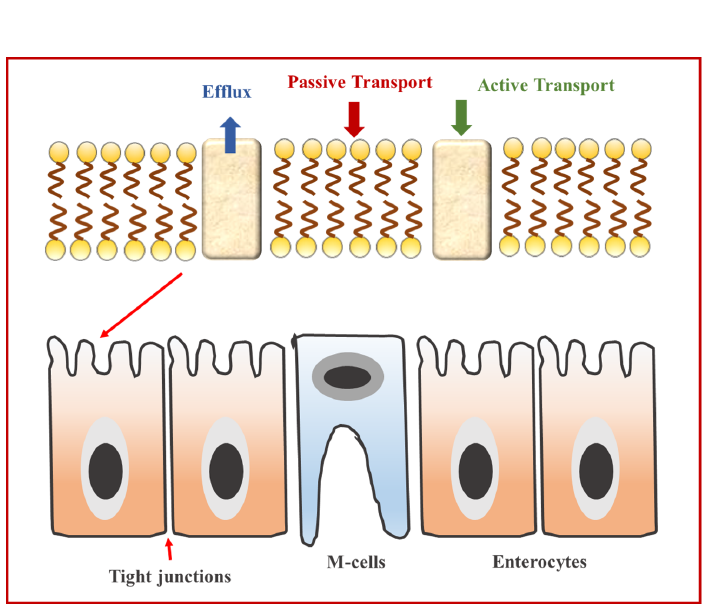
Figure 4. Schematic representation of the mechanisms involved in the absorption of bioactive compounds in the gastrointestinal tract. The absorption of bioactive agents may be limited due to their transport across the epithelium cell through passive, active or efflux mechanisms. Most bioactive compounds are usually absorbed in the upper gastrointestinal tract (GIT) and therefore do not reach the GIT and then encounter the M-cells. down the GIT and then encounter the